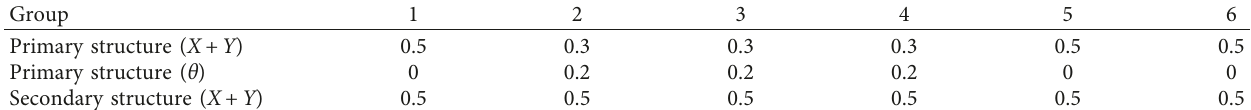
Table 1: Weight values of the coupled system’s seismic response under different combinations.